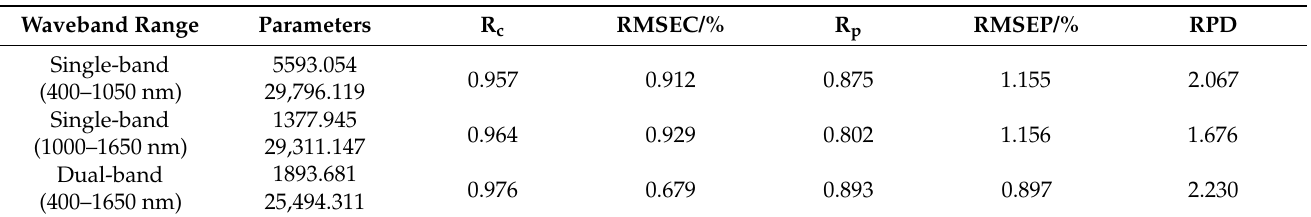
Figure 6. SG smoothing pretreatment spectral of dual-band. ( a ) Spectral curve before data fusion, and ( b ) spectral curve after data fusion. Different colors denote the raw spectral reflectance curves of different samples. There were 40 samples of each tea variety, with a total number of 80 samples, i.e., 80 samples and 80 spectral curves. Table 2. Predictive performances of the LS–SVR model for tea polyphenol content detection in different waveband